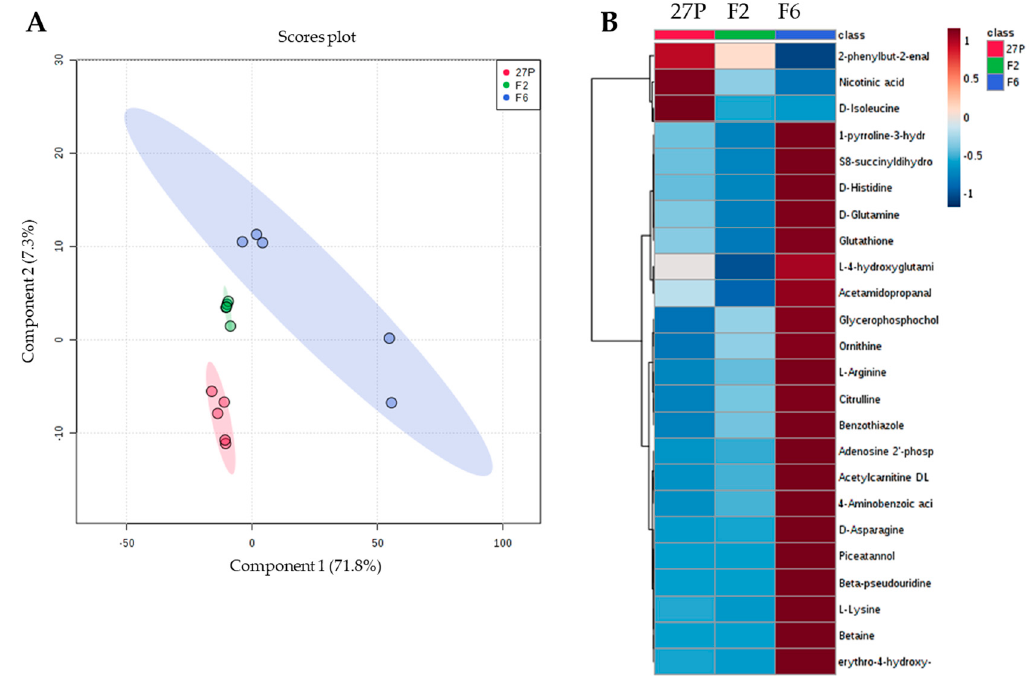
Figure 2. PLS-DA scores plot showing di ff erences between the not ethanol-treated cells of the parental S. cerevisiae 27P and the recombinant F2 and F6 strains ( A ) and resulting heat map of the top 25 significantly changed metabolites selected by VIP scores ( B ). Legend. PLS-DA scores plot of PC1 vs. PC2: the explained variances are shown in brackets (A). The colored boxes indicate the relative concentrations of the corresponding metabolite in each group under study. The color scale is log2 transformed value and indicates relatively high (red) and low (blue) metabolite levels